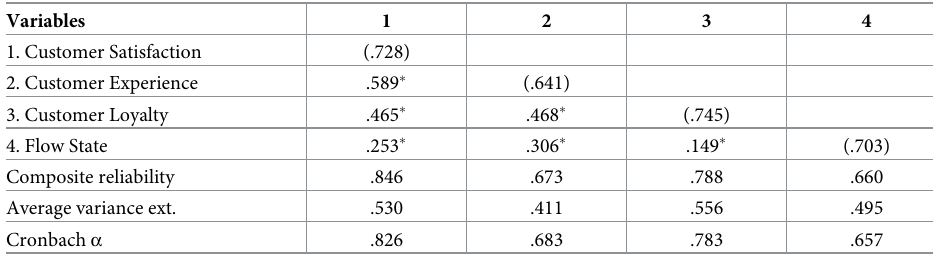
Table 2. Construct descriptives, reliability and